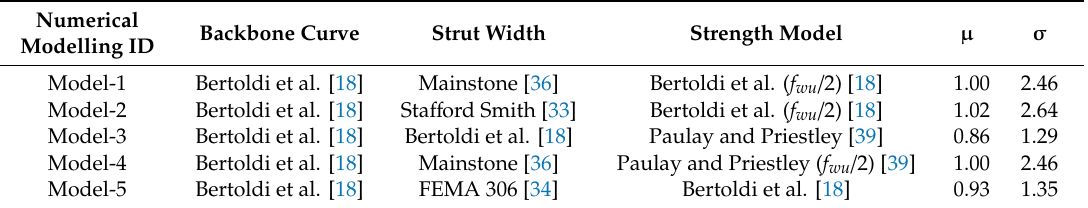
Table 5. Summary of the best numerical models for the strong masonry infill typology, as function of strut width and strength formulations.